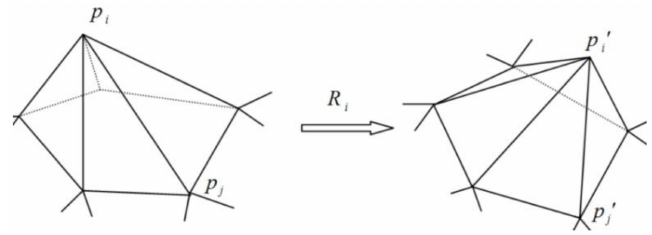
Figure 4. Rigid transformation of a deformation element.